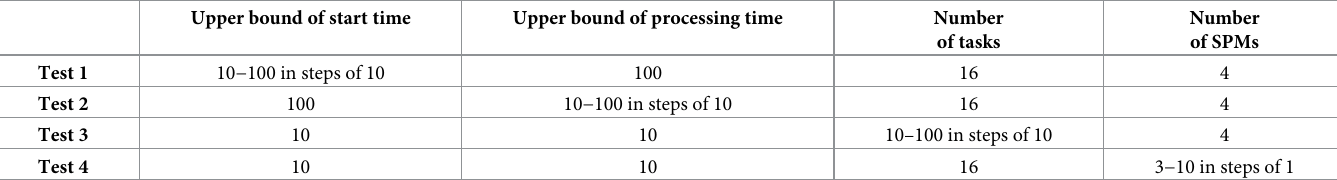
In test 1, as detailed in Table 2, the start time was taken as the variable. The start time value range was from 1 to the upper bound in integers, where the upper bound was changed from 10 to 100 in steps of 10. The processing time was set to uniform random integers in the range of 1 − 100. N was 16, and M was 4.